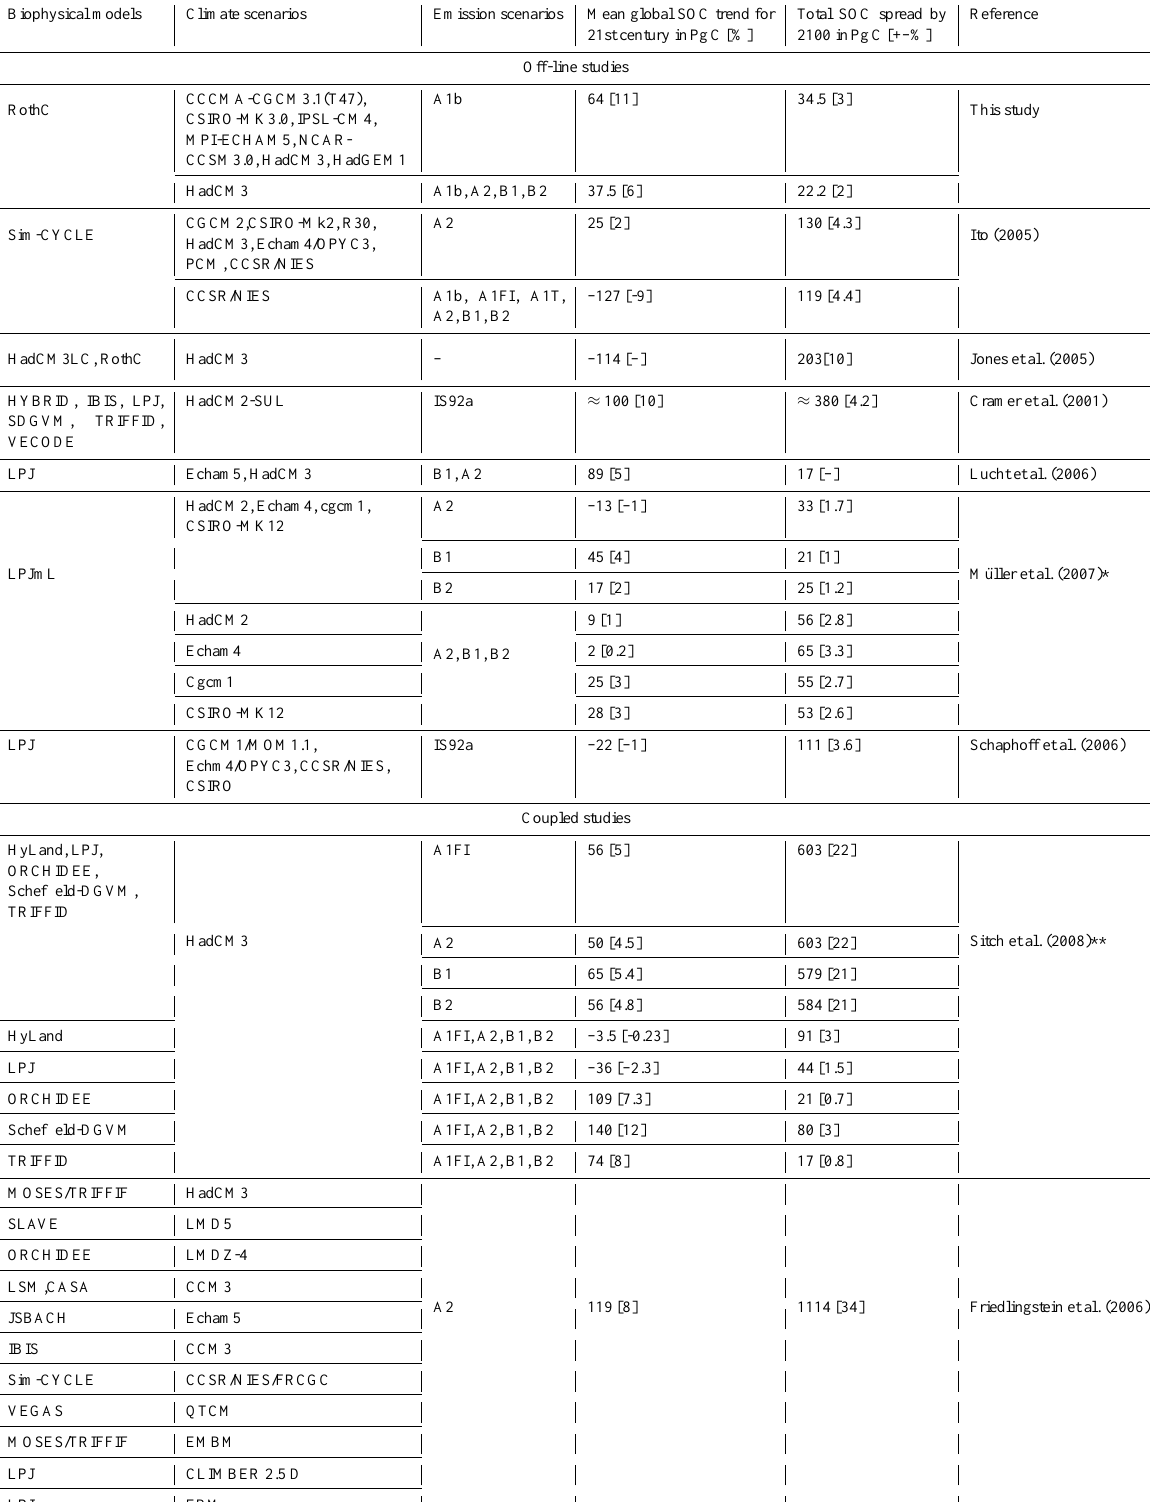
Table 4. Literature compilation of global SOC trends and variability in 2100 compared to our study. Please refer to respective studies for details of the simulations and model